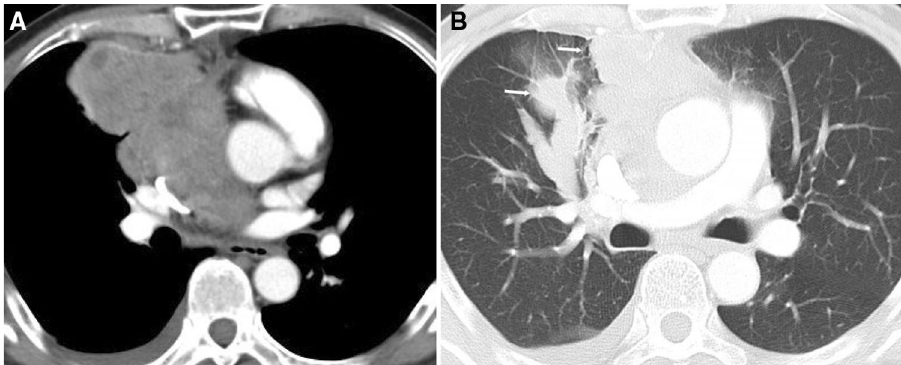
Figure 3. High-risk thymoma (type B2) in a 66-year-old man with pericardial mass and lung invasion. Contrast enhanced CT scan (Axial 5.0 mm) obtained at the level of the aortic root ( A ) and pulmonary trunk ( B ) shows tumor invading the pericardium and form large soft tissue mass inside the pericardium. The interface between the tumor and lung was lost, with compression and effusion in the lung (white arrow). This patient died 23.8 months since the first CT examination.